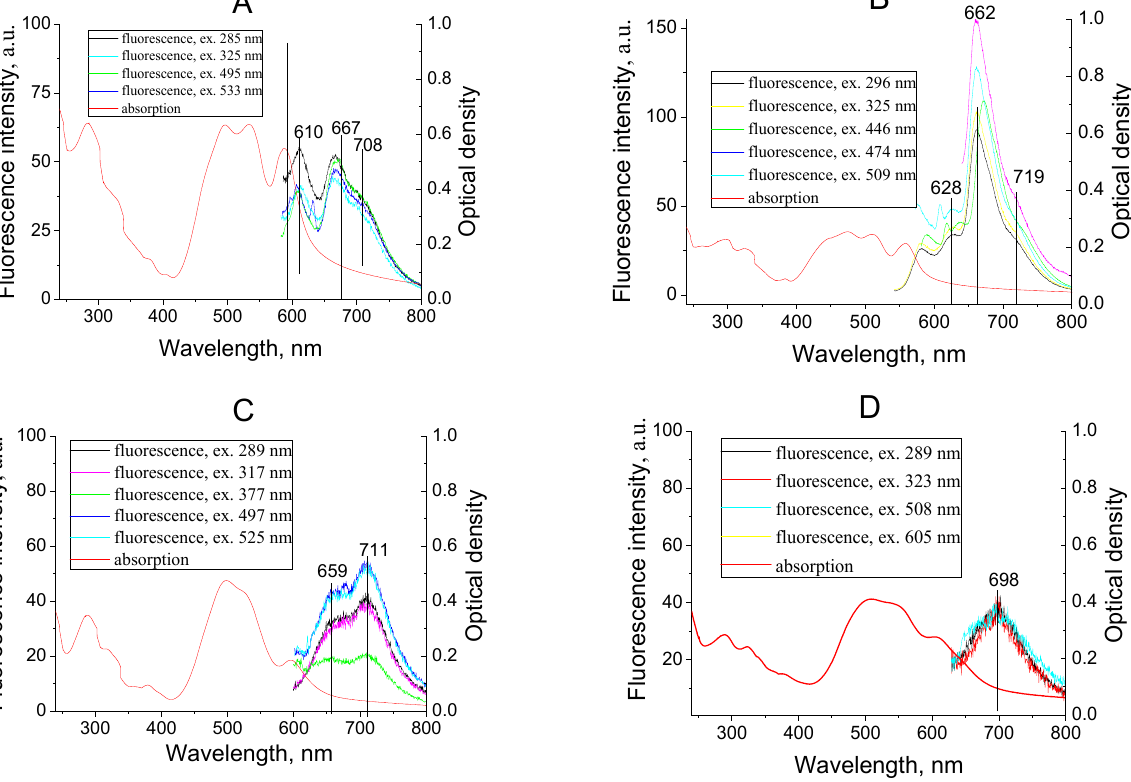
Figure 8. Absorption and fluorescence of one-component dye films I ( A ), II ( B ), III ( C ), IV ( D ), fabricated by thermal vacuum deposition.